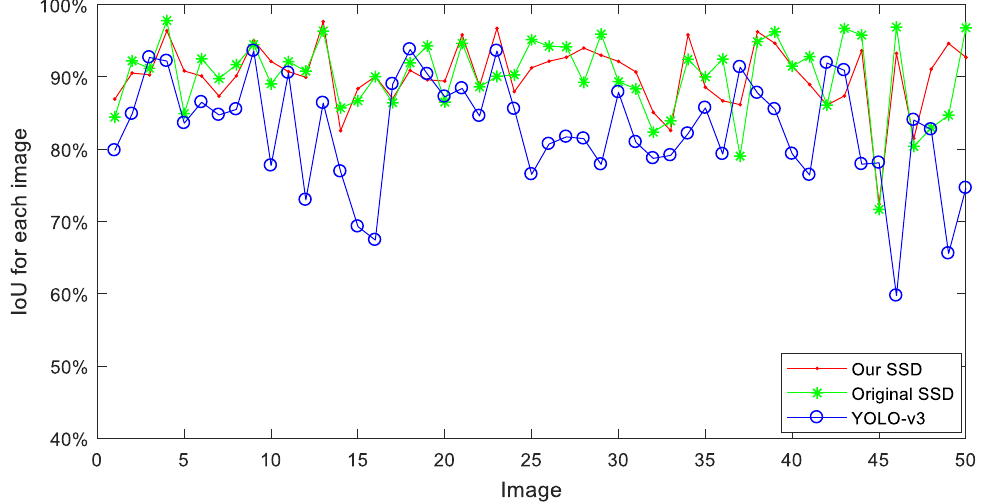
Figure 9. Comparison of Intersection Over Union (IoU) for each test image between our SSD, original SSD and YOLO-v3 method. To display the detail value points, only 50 images sample are randomly selected in test set. Table 3. Comparison of the mean Intersection Over Union (IoU) for the three methods. Our SSD